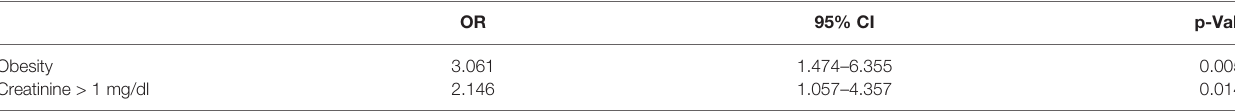
TABLE 7 | Risk factors for major complications (Clavien – Dindo ≥ 3) after RC — multivariate